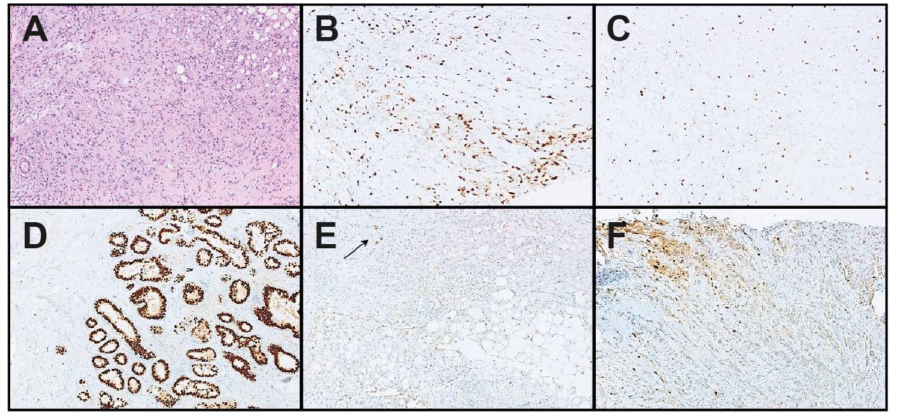
Figure 2. Histological review of one case reported as falsely negative for PGR and MKI67 by two sites. Case #2 was a pleomorphic invasive lobular breast cancer. ( A ): Hematoxylin and eosin staining ( × 200). ( B , C ): Heterogeneous immunohistochemical (IHC) expression of Ki-67 ( × 200). ( D ): Internal positive control (non-neoplastic breast epithelium) in the progesterone receptor (PgR) IHC ( × 200). ( E , F ): Heterogeneous IHC expression of PgR (mostly negative, but focally positive with strong intensity) ( ×